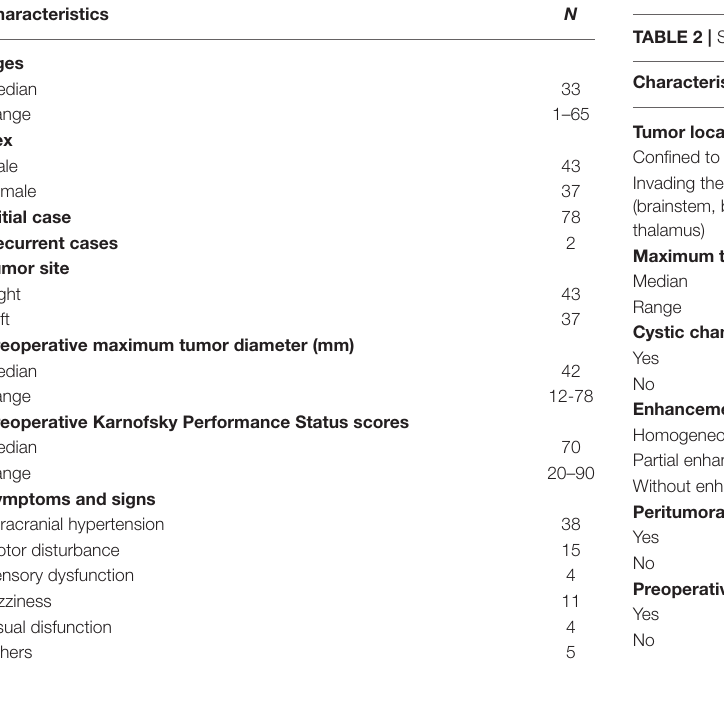
TABLE 1 | Summary of preoperative clinical and radiological features in 80 patients. Characteristics